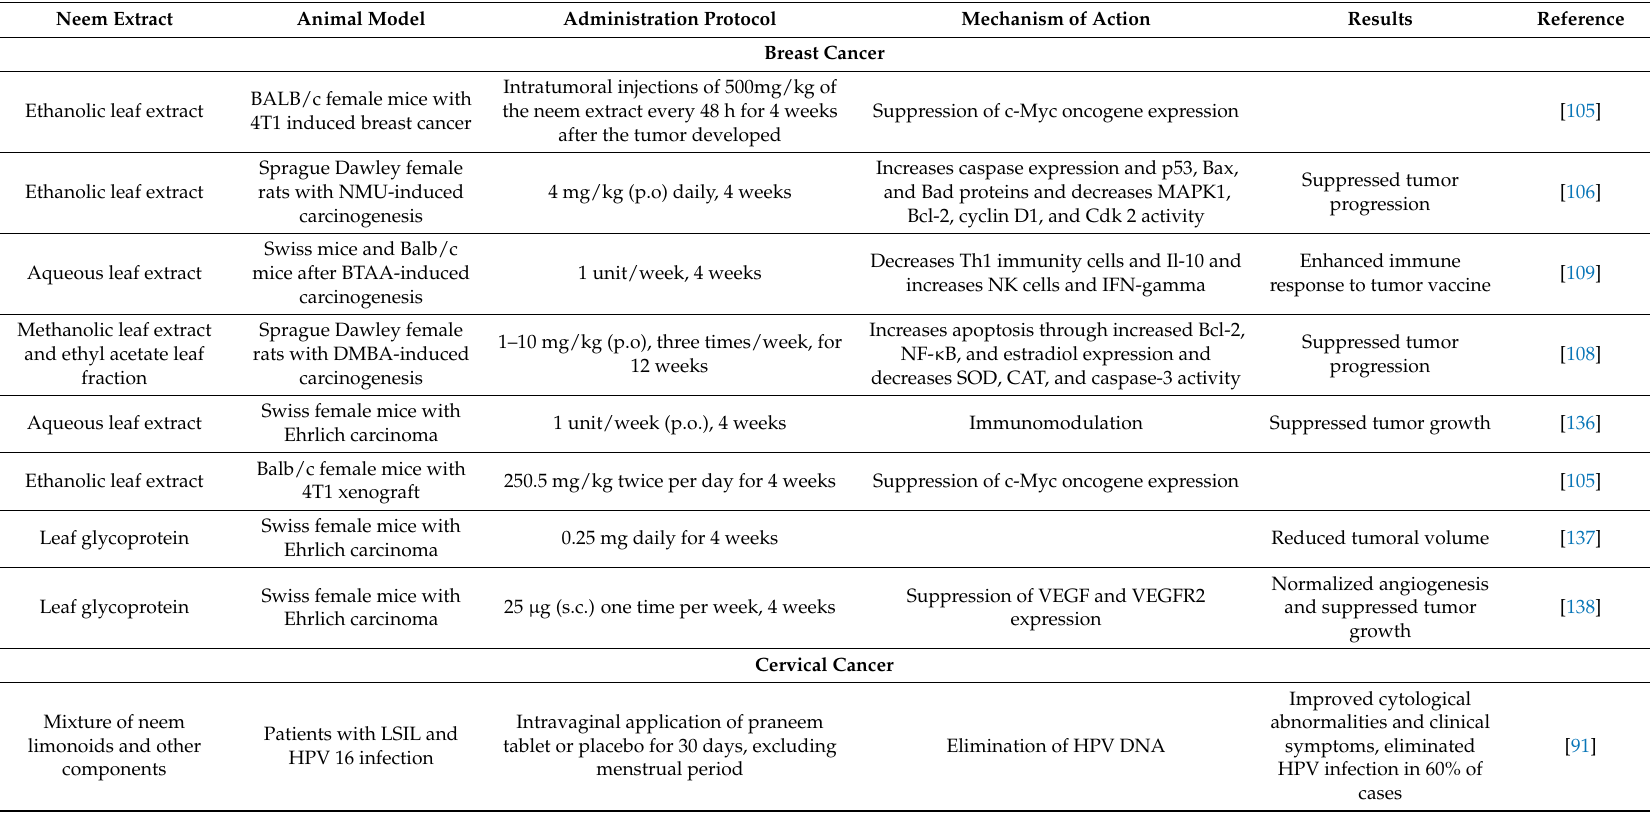
Table 2. Comparative anticarcinogenic properties of neem extracts in gynecological cancers based on in vivo